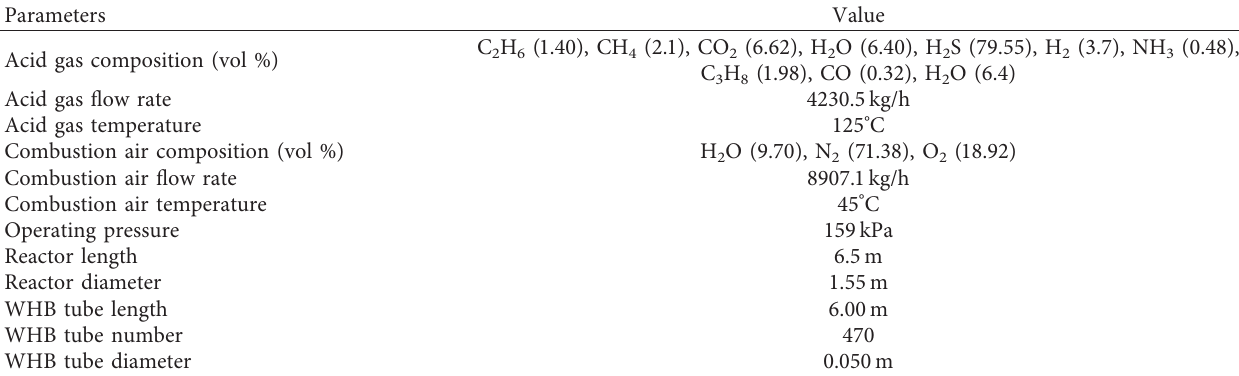
Figure 3: The scheme of the Table 3: The structure parameters and inlet operating condition.